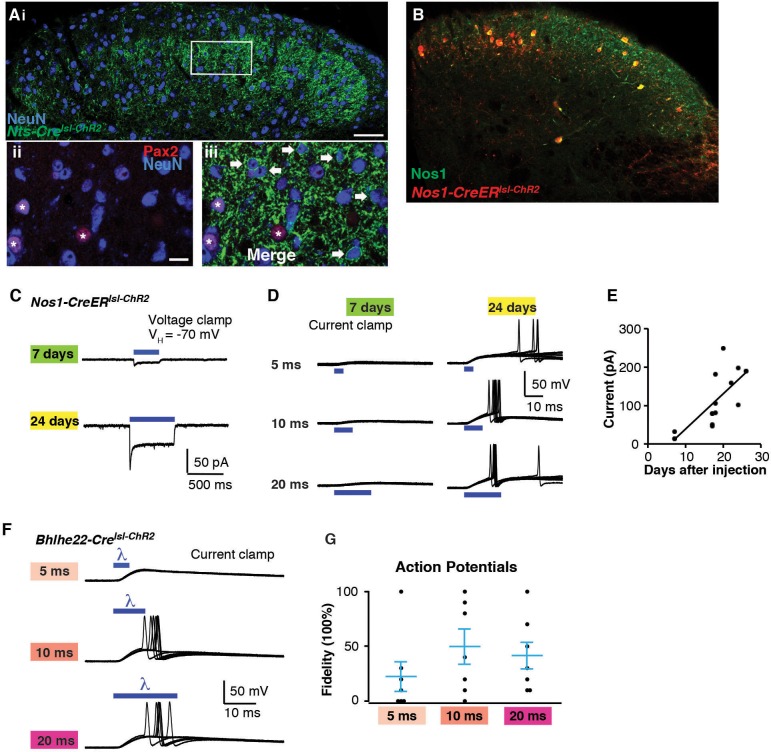
Optogenetic activation of spinal interneurons.(A) Confocal image of transverse spinal cord section from Nts-Crelsl-ChR2 mice. (i) ChR2-YFP signal (green) is mainly found in lamina IIo-III. Inhibitory neurons are labeled with Pax2 in red (ii, asterisk). Little to no co-localization is found between ChR2 (arrow) and Pax2. (iii). Approximately 50% of Pax2-negative neurons show recombination. (B) Confocal image of transverse spinal cord section from Nos1-CreERlsl-tdT mice. Nos1 (green) was co-labeled with tdT. Approximately 95% of recombined cells show Nos1 expression; up to 90% (depending on dose of tamoxifen) of Nos1-expressing neurons show recombination (C) Blue light-induced inward current from mice of different survival time after tamoxifen injection (7 and 24 days). (D) Response to blue light pulses (5 ms, 0.3 Hz) in Nos1-CreER neurons. Note that blue light induced only small EPSP without action potentials 7 days after tamoxifen injection. (E) Relationship between days after tamoxifen injection and peak inward current evoked by blue light. (Equation for regression: y = 9.15 x –52.57) (F) Response to different light pulse duration in Bhlhe22-Crelsl-ChR2 neurons. G. Fidelity in response to different light pulse duration.